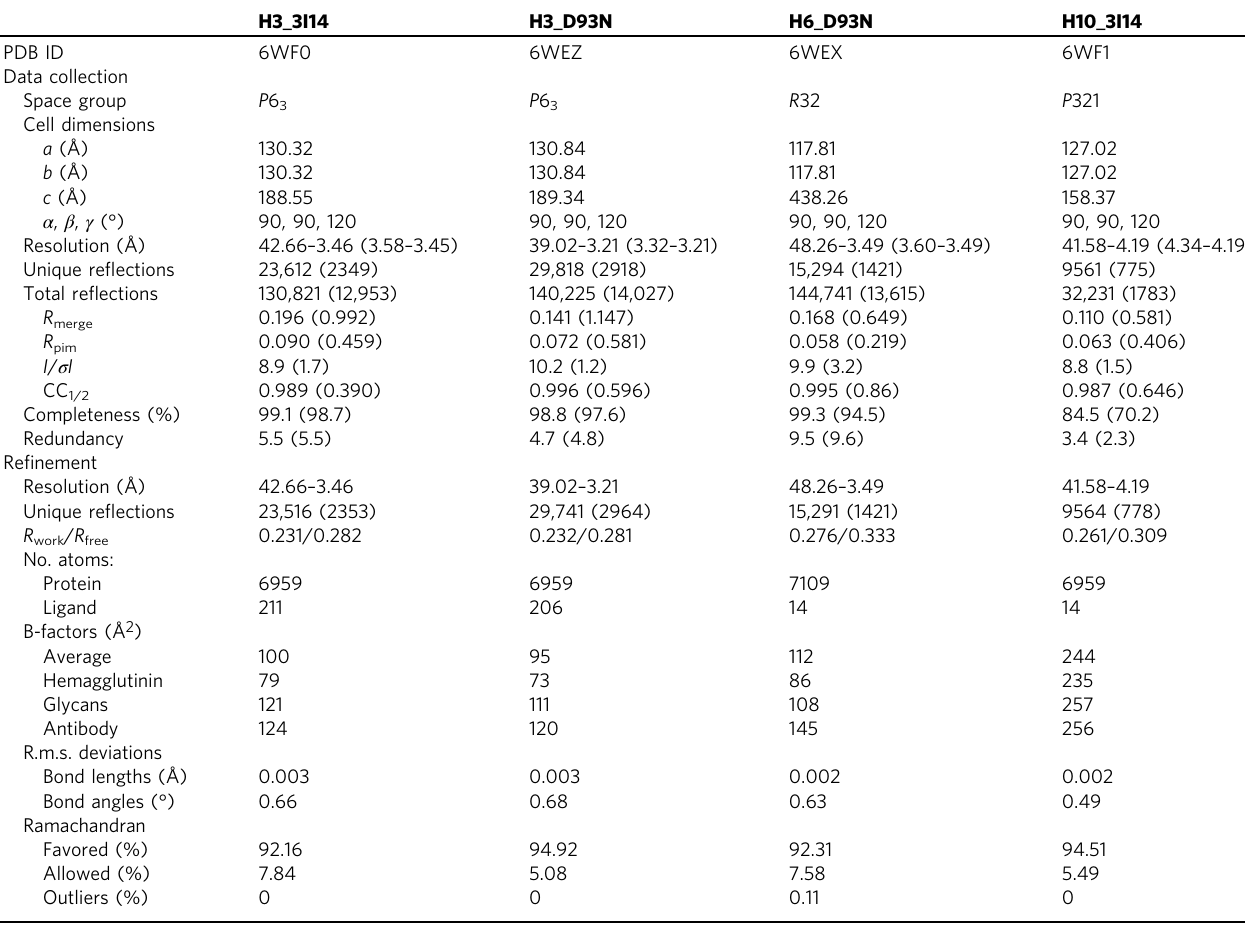
Table 2 X-ray data collection and crystallographic re fi nement statistics.